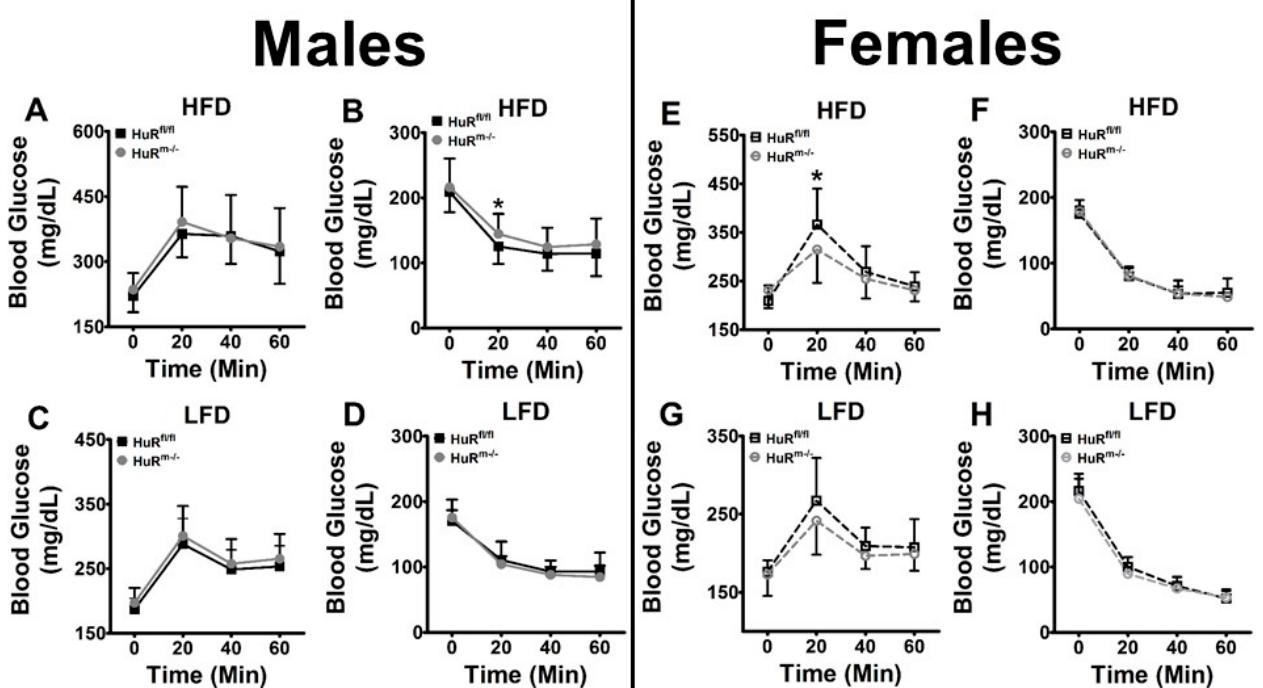
Figure 3. HuR m − / − females but not males have increased glucose clearance relative to controls on HFD ( A ) GTT at 20 weeks of age for male control (black) or HuR m − / − (grey) mice fed HFD ( n = 19). ( B ) ITT at 20 weeks of age for male control (black) ( n = 18) or HuR m − / − (grey) ( n = 19) mice fed HFD. ( C ) GTT at 20 weeks of age for male control (black) ( n = 14) or HuR m − / − (grey) ( n = 16) mice fed LFD. ( D ) ITT at 20 weeks of age for male control (black) ( n = 14) or HuR m − / − (grey) ( n = 16) mice fed LFD. ( E ) GTT at 20 weeks of age for female control (black) ( n = 19) or HuR m − / − (grey) mice fed HFD ( n = 18). ( F ) ITT at 20 weeks of age for female control (black) ( n = 19) or HuR m − / − (grey) ( n = 18) mice fed HFD. ( G ) GTT at 20 weeks of age for female control (black) ( n = 16) or HuR m − / − (grey) ( n = 16) mice fed LFD. ( H ) ITT at 20 weeks of age for female control (black) ( n = 16) or HuR m − / − (grey) mice fed LFD ( n = 16). * p ≤ 0.05.